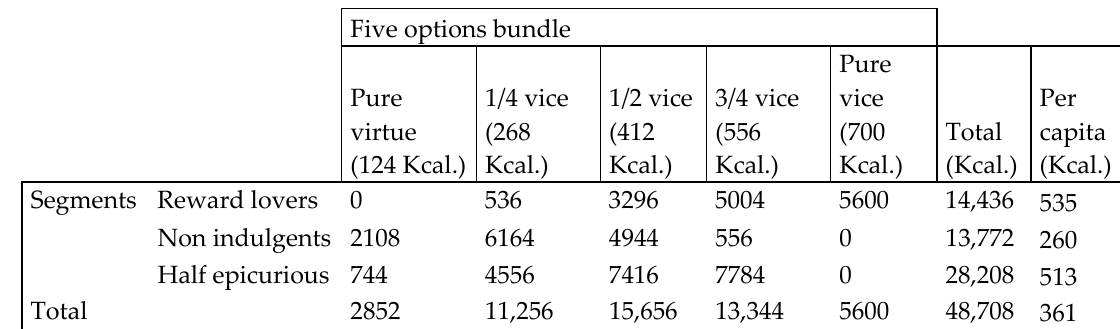
Table 5. Segments food choice. Five options bundle (calories).